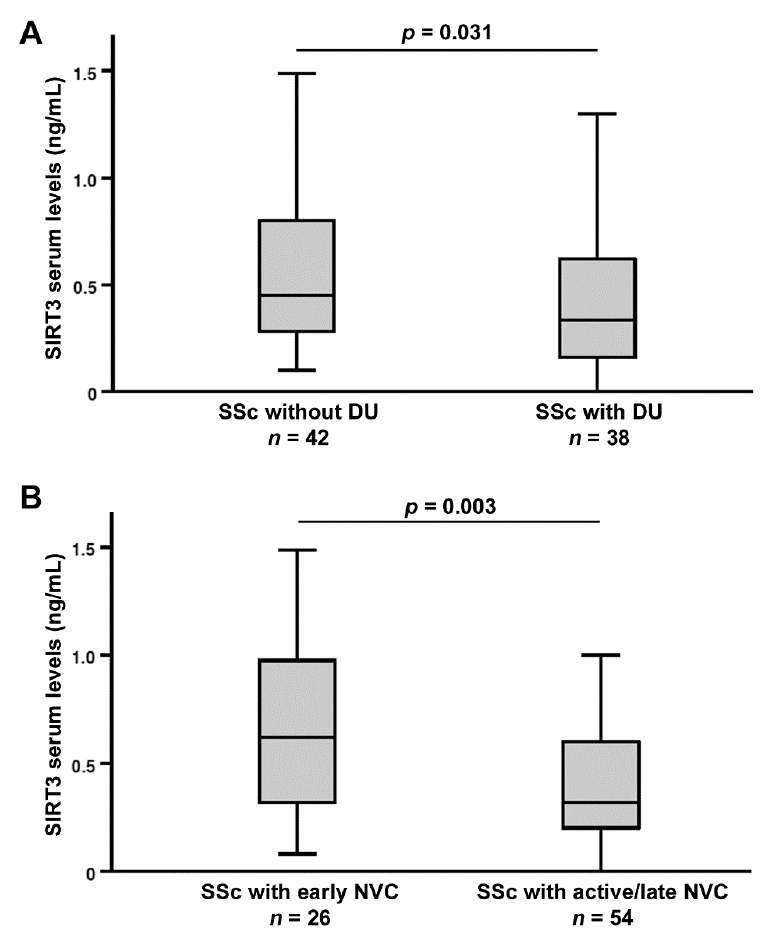
Figure 6. Association of serum sirtuin 3 (SIRT3) levels with the severity of peripheral microvascular damage in systemic sclerosis (SSc) patients. ( A ) Decreased SIRT3 levels in SSc patients with ischemic digital ulcers (DUs). ( B ) SIRT3 levels in SSc patients stratified according to “early” and “active/late” nailfold videocapillaroscopy (NVC) patterns. Data are presented as box plots. Each box denotes the 25th to 75th percentiles. Lines outside the boxes are the 10th and 90th percentiles. Lines inside the boxes denote the median, circles denote the outliers, and asterisks denote the extreme values; p values are indicated.